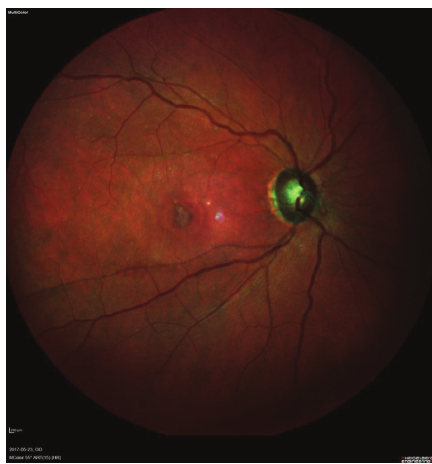
Figure 1: A macular hole closed surgically with a lens capsular flap.